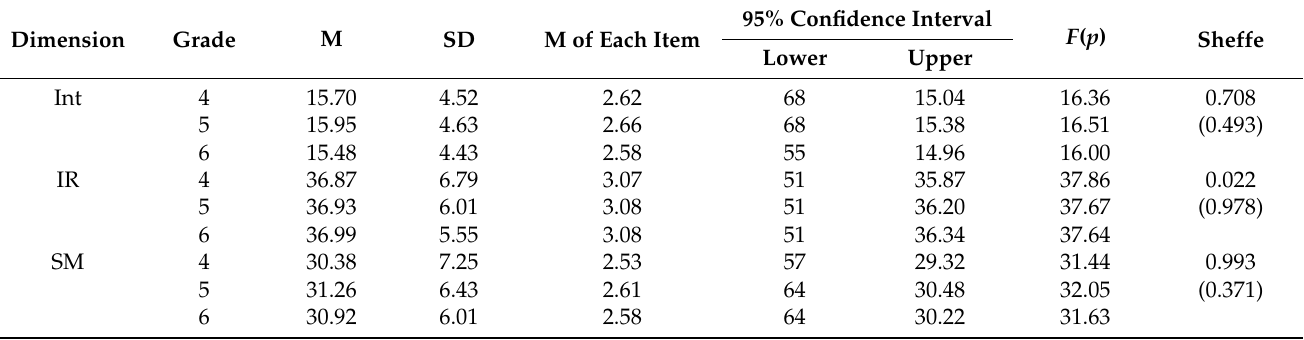
Table 8. The difference in emotional intelligence by